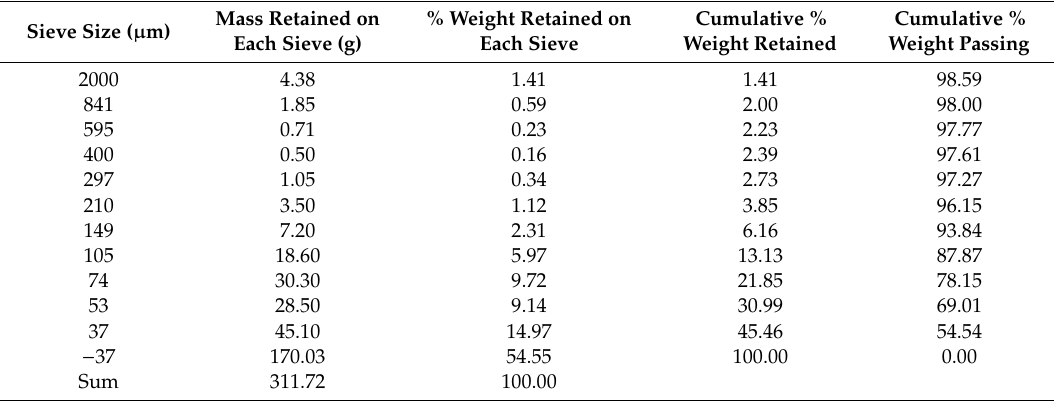
Table 3. Sieve analysis of flotation feed sample